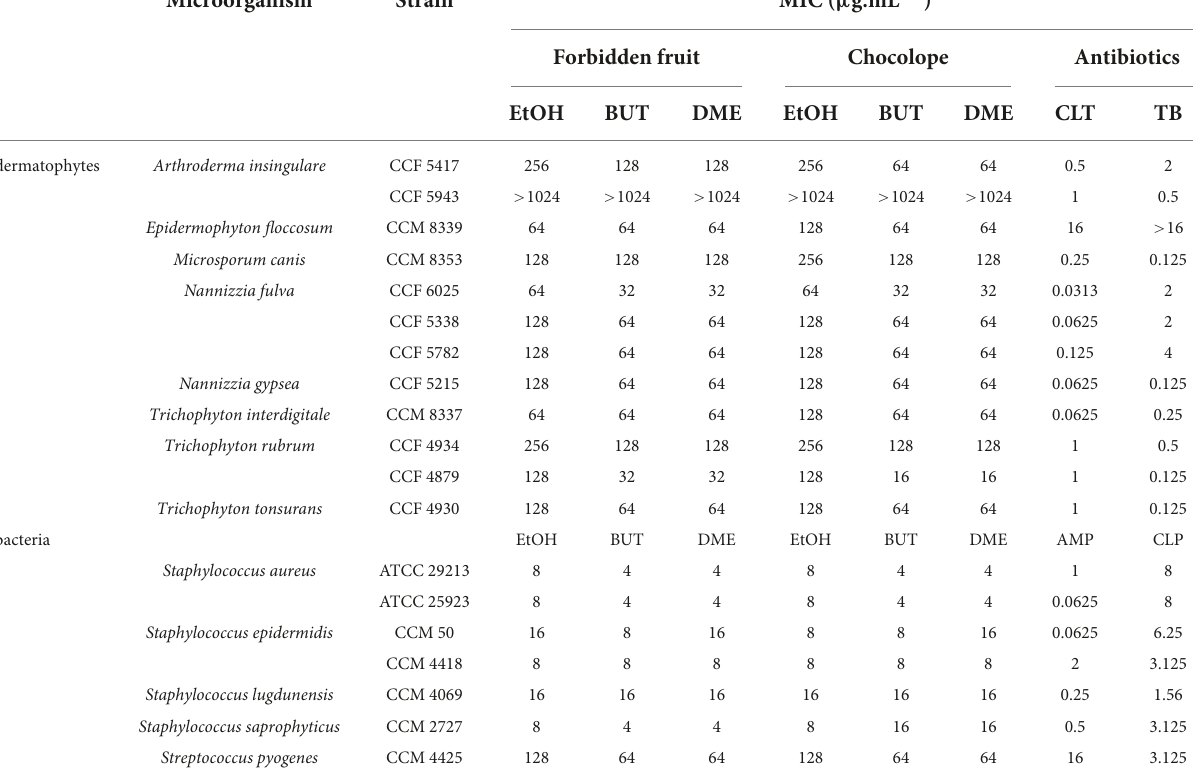
TABLE 3 Minimal inhibitory concentrations (MIC) ( µ g/mL) of cannabis extracts against selected bacteria and dermatophytes. Microorganism Strain MIC ( µ g.mL − 1 )